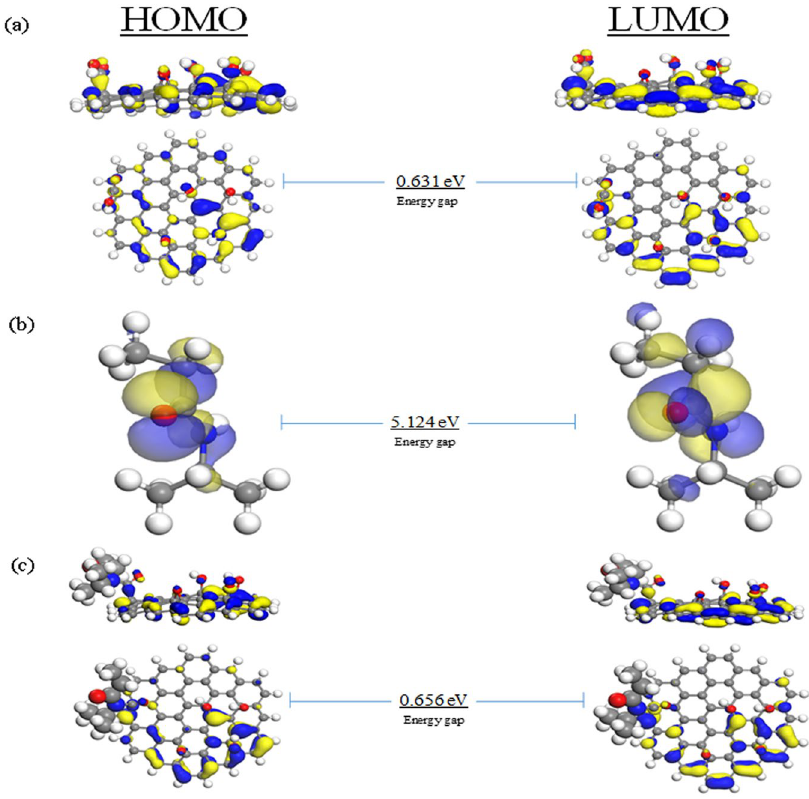
Figure 2. The isosurfaces of HOMO and LUMO of ( a ) GO, ( b ) PNIPAM monomer, and ( c ) GO/NIPAM calculated by